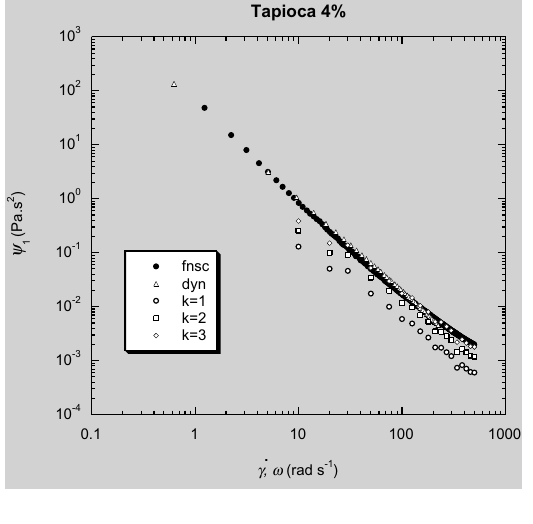
Figure 6: First normal stress coefficient from flow test down curve (fnsc), first normal stress coefficient predicted with Eq. 4 (dyn), and first normal stress coefficient predicted with Eq. 5 using different values of the empirical factor K (K = 1, K = 2, K = 3) for tapioca at 4 %